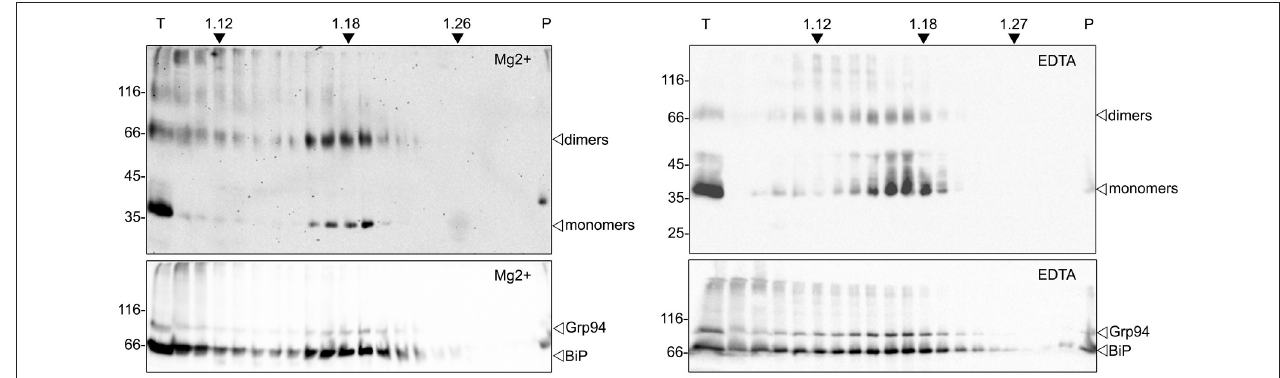
FIGURE 6 | zein-hBMP2ad cofractionates with the ER. Hundred milligrams of fresh leaves from zein-hBMP2ad line #23 were homogenized in sucrose buffer, in the absence of detergent. The homogenates were fractionated by centrifugation on isopycnic sucrose gradient (16–65% w/w) in the presence of MgCl 2 (left panels) or EDTA (right panels). Collected fractions were analyzed by SDS-PAGE followed by immunoblotting with anti-Flag antiserum (upper panels) or with a mix of anti-BiP and anti-Grp94 antisera (bottom panels). T, total extract; P, pellet at the bottom of the tube. Numbers at top indicate the density (g/ml) of sucrose. Numbers at left indicate the position of molecular mass markers, in kD.